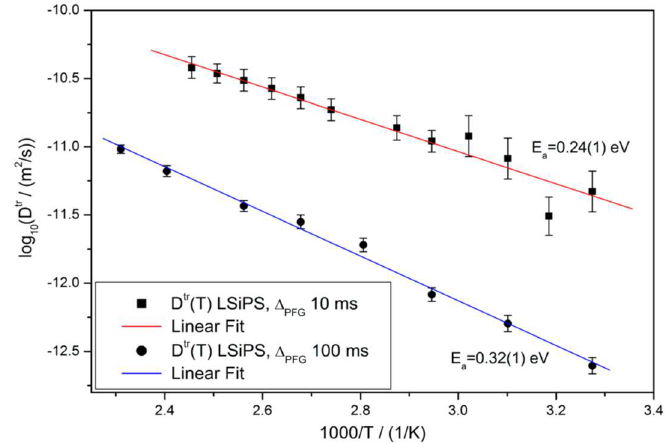
Figure 13. Arrhenius plots of variable temperature diffusion in tetra-LSiPS, at both 10 ms and 100 ms diffusion time [41] .